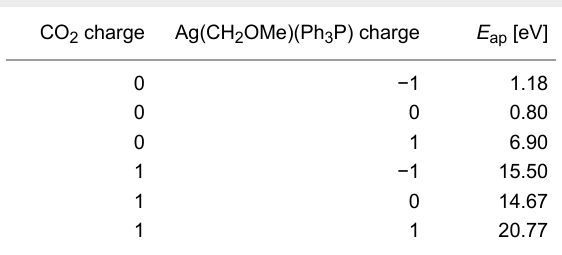
Table 5: Appearance energy (Equation 2) of differently charged [AgCH 2 OMe(PPh 3 )] and CO 2 fragments from dissociation of monomeric 2